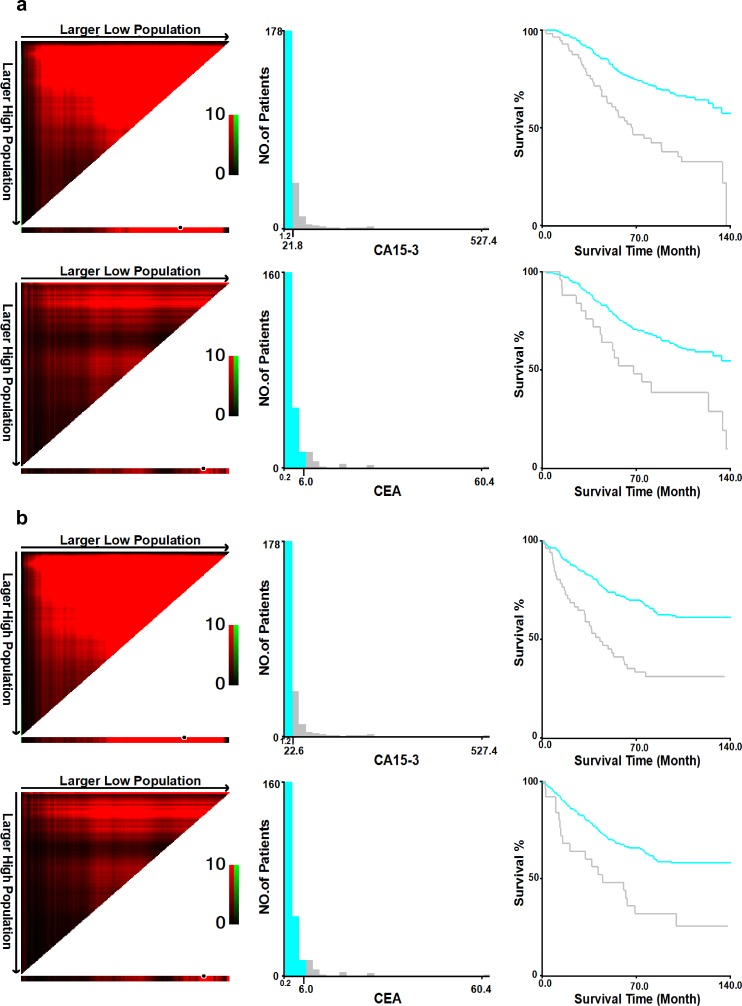
Identification of optimal cut-off values to define the CEA and CA15-3 levels as high or low.